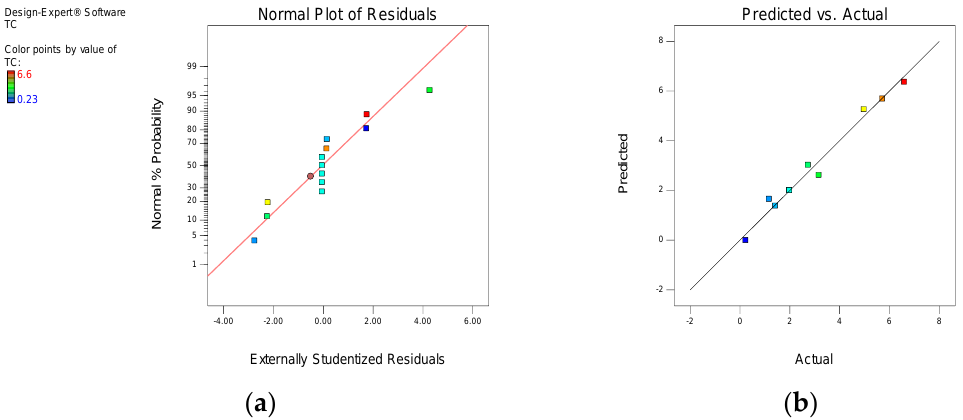
Figure 18. ( a ) Normal Plot for the Residual and ( b ) Predicted Versus Actual Plot for the FS model.